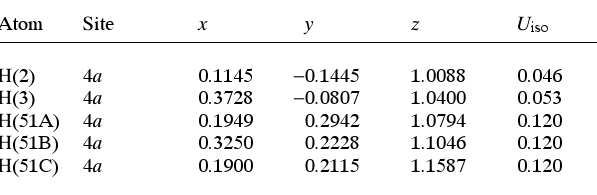
Table 2. A tomic coordin a tes a nd displ a cement p a r a meters (in Å 2 ) . A